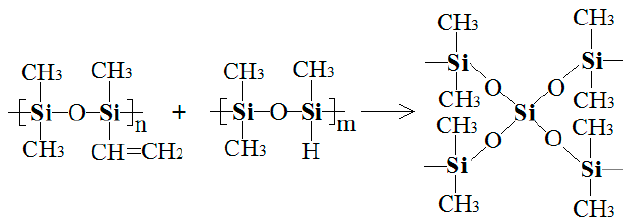
Scheme 1. Curing reaction mechanism of silicone A and B.